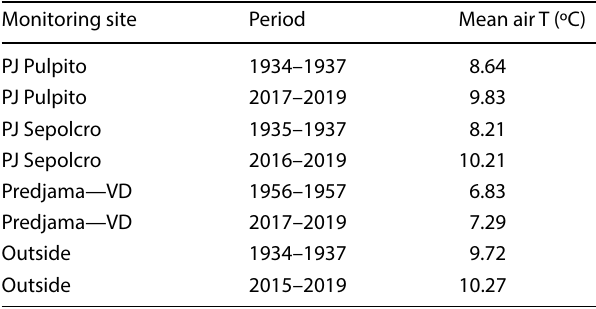
Table 2 Comparison between mean air temperatures (in °C) for his- torical and modern periods for Postojnska Jama (PJ) sites (Pulpito, Sepolcro), Predjama site (VD—Velika Dvorana) and outside Monitoring site